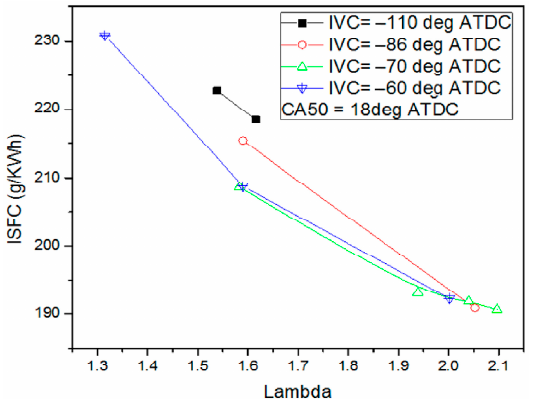
Figure 12. Comparison of ISFC with different intake closure angle and Lambda.